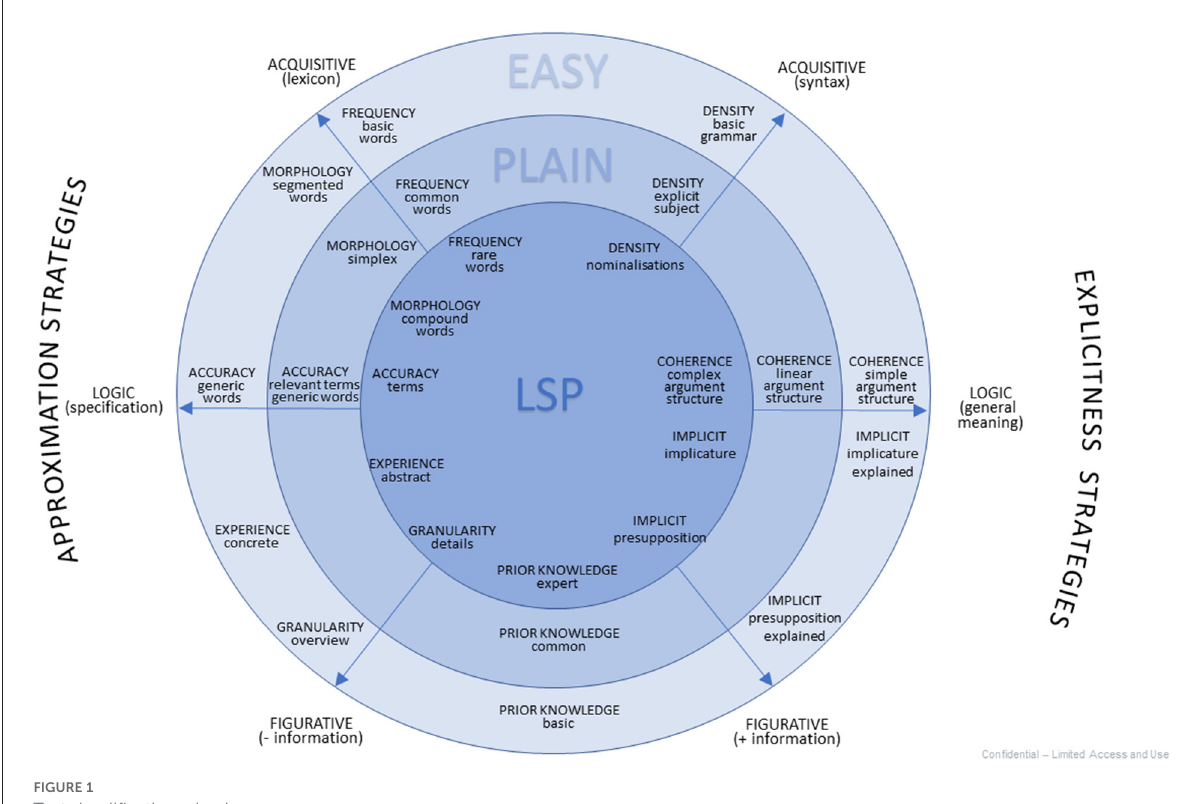
FIGURE1 Text simplification